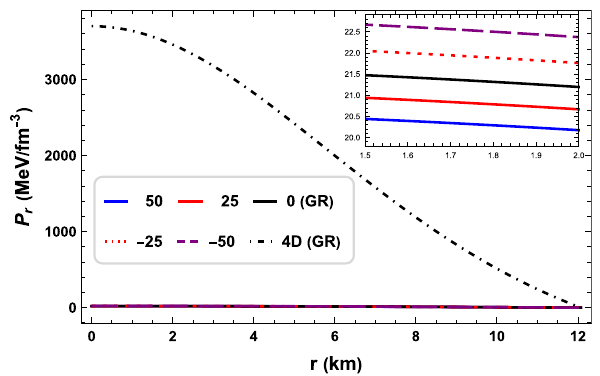
Fig. 1 Radial variation of matter density ( ρ ) in PSR J0348+0432 for different α values in 5D with α = 0 in 4D